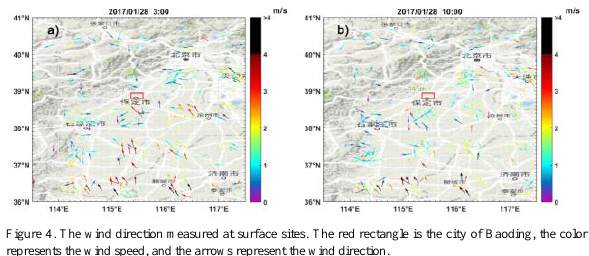
Figure 4. The wind direction measured at surface sites. The red rectangle is the city of Baoding, the color represents the wind speed, and the arrows represent the wind direction.